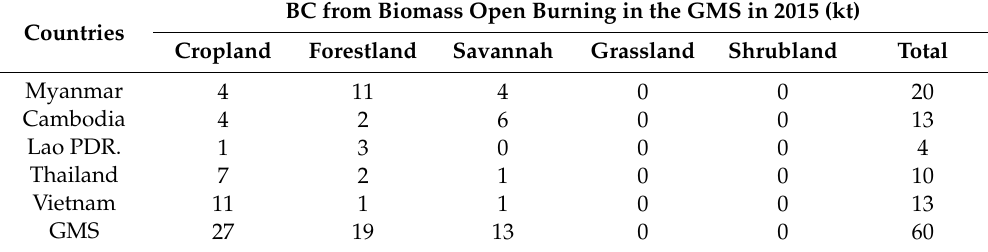
Table A9. The actual amount of BC from biomass open burning classified by vegetation types in the GMS in 2015. Countries